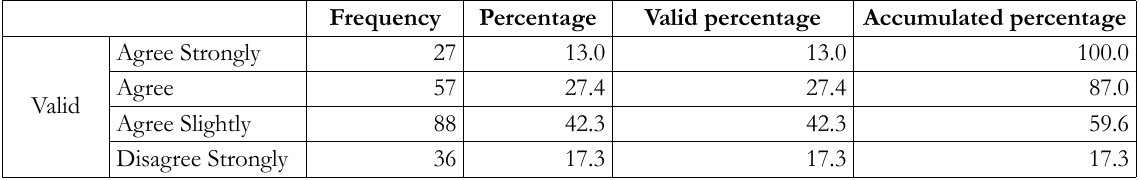
Table 5. Item. “Are you qualified for using ICT in the classroom?”